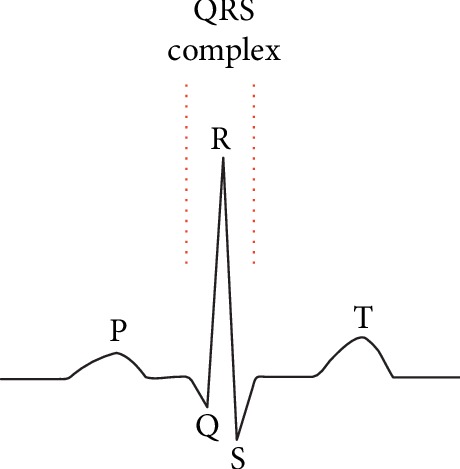
A sample ECG signal.